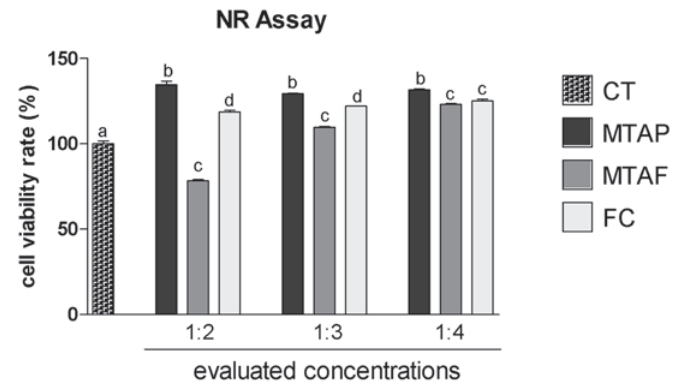
Figure 3- Cell viability rate (%) according to NR assay in human dental pulp cells (hDPCs) exposed to MTA Plus (MTAP), MTA Fillapex (MTAF), FillCanal (FC) and culture medium used as control (CT). Bars with different letters represent (cid:86)(cid:76)(cid:74)(cid:81)(cid:76)(cid:191)(cid:70)(cid:68)(cid:81)(cid:87)(cid:3)(cid:71)(cid:76)(cid:73)(cid:73)(cid:72)(cid:85)(cid:72)(cid:81)(cid:70)(cid:72)(cid:86)(cid:3)(cid:69)(cid:72)(cid:87)(cid:90)(cid:72)(cid:72)(cid:81)(cid:3)(cid:74)(cid:85)(cid:82)(cid:88)(cid:83)(cid:86)(cid:3)(cid:76)(cid:81)(cid:3)(cid:72)(cid:68)(cid:70)(cid:75)(cid:3)(cid:70)(cid:82)(cid:81)(cid:70)(cid:72)(cid:81)(cid:87)(cid:85)(cid:68)(cid:87)(cid:76)(cid:82)(cid:81)(cid:3)(cid:82)(cid:73)(cid:3)(cid:87)(cid:75)(cid:72)(cid:3)(cid:80)(cid:68)(cid:87)(cid:72)(cid:85)(cid:76)(cid:68)(cid:79)(cid:3)(cid:72)(cid:91)(cid:87)(cid:85)(cid:68)(cid:70)(cid:87)(cid:86)(cid:3)(cid:11)(cid:83)(cid:31)(cid:19)(cid:17)(cid:19)(cid:24)(cid:12)